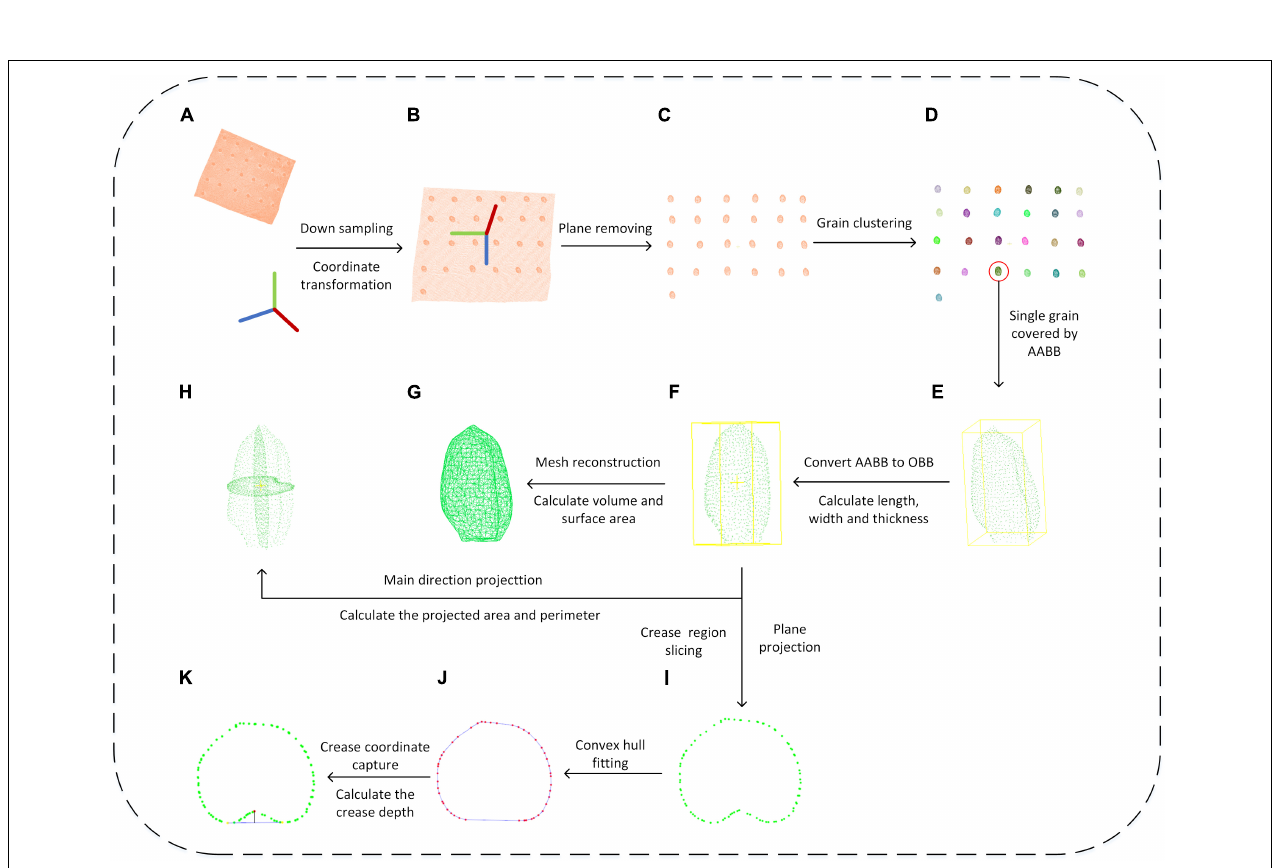
FIGURE 5 | Wheat grain point cloud processing and trait extraction scheme. (A–K) Indicated the process of each step.